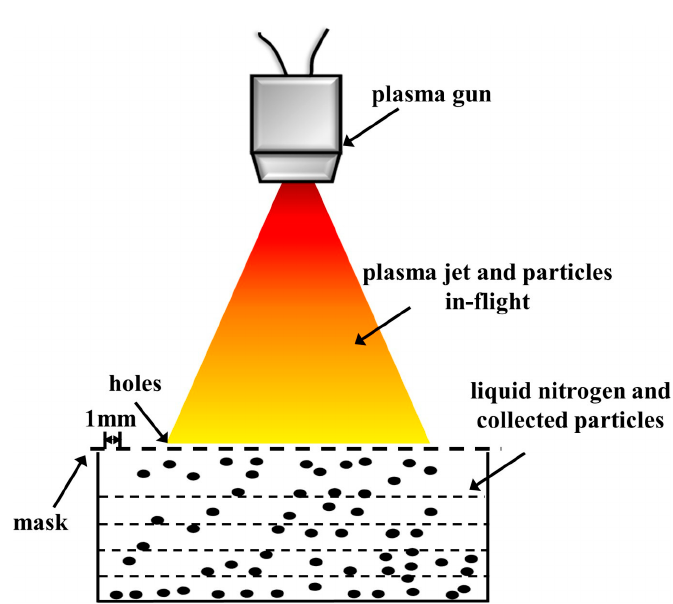
Figure 2. Schematic illustration of particles’ in-flight collecting apparatus. Table 1. Spray parameters of yttria-stabilized-zirconia (YSZ) by supersonic atmospheric plasma spraying (SAPS).